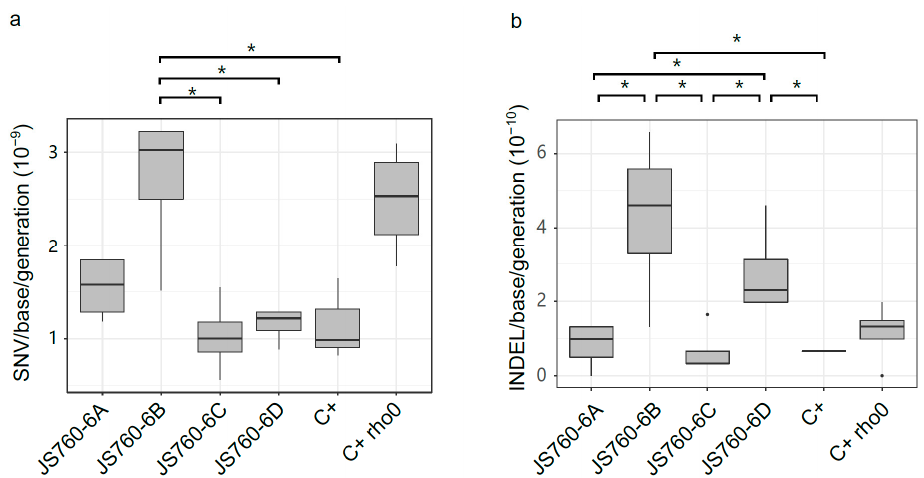
Figure 1. Mutation rates among the six strains. ( a ) SNV rate. ( b ) INDEL rate. The “*” symbols in the panels a and b indicate statistical significance with t test p < 0.05. The genotypes of the six strains are as follows: JS760-6A ( MRPL25 + atp3 G348T ), JS760-6B ( mrpl25 ∆ ATP3 + ), JS760-6C ( MRPL25 + ATP3 + ), JS760-6D ( mrpl25 ∆ atp3 G348T ), C+ (positive control), C+ rho0 (negative control).